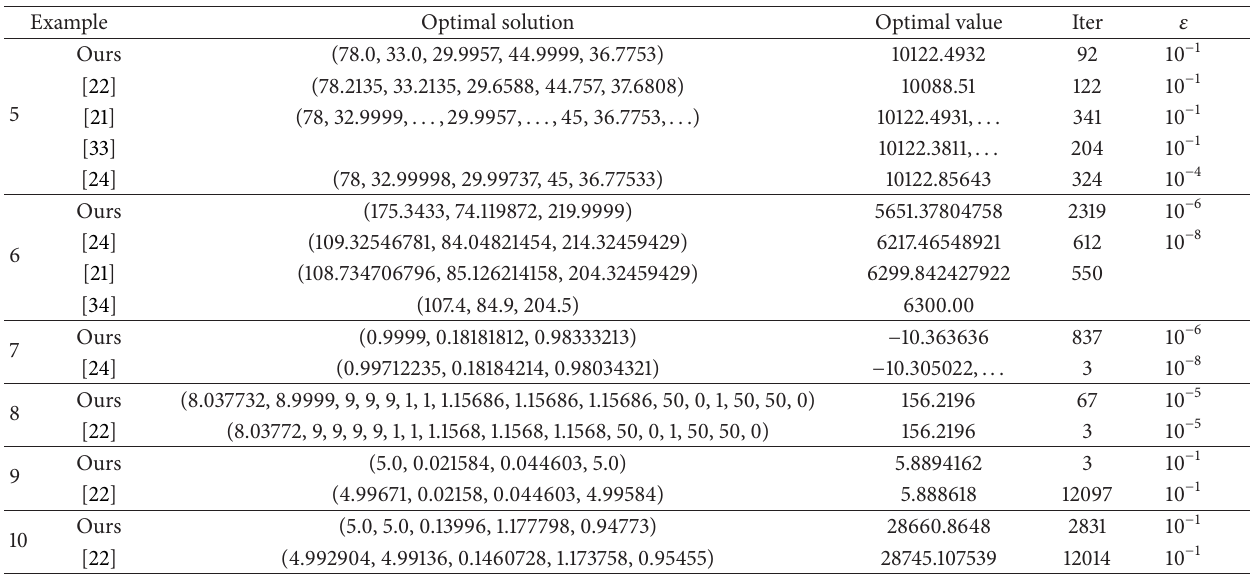
Table 2: The numerical results for Examples